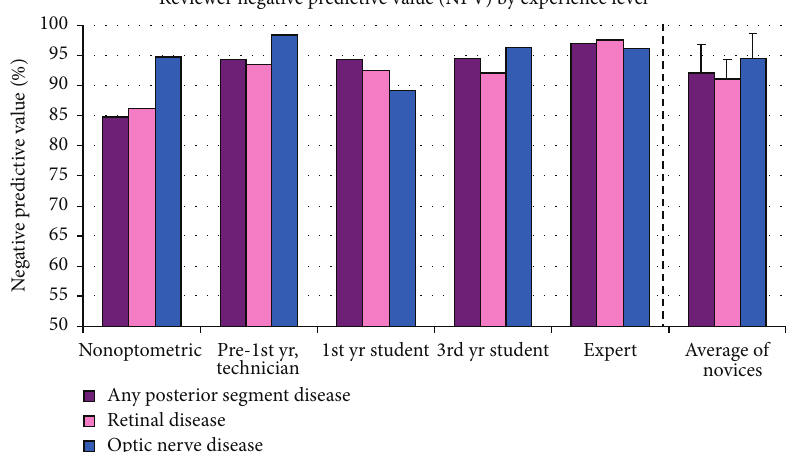
Figure 4: Reviewers’ Negative Predictive Value (NPV), based on data provided with iWellnessExam™. On average, novice reviewers were able to correctly predict whether a subject was normal > 90% of the time, with comparable performance to expert